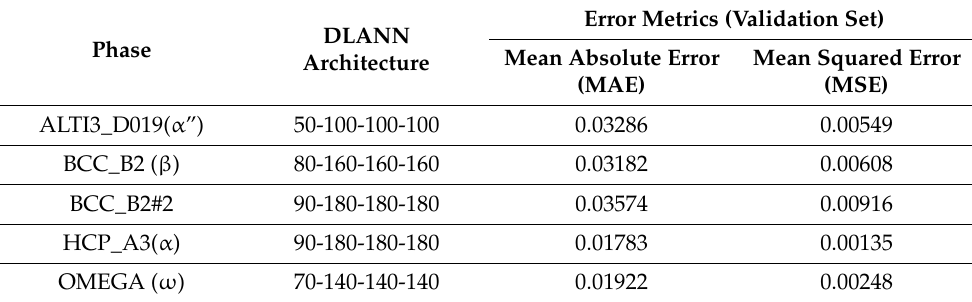
Table 2. Performance metrics for deep learning artificial neural network (DLANN) models for various phases for the Ti-Nb-Zr-Sn system. Error Metrics (Validation DLANN Phase Architecture